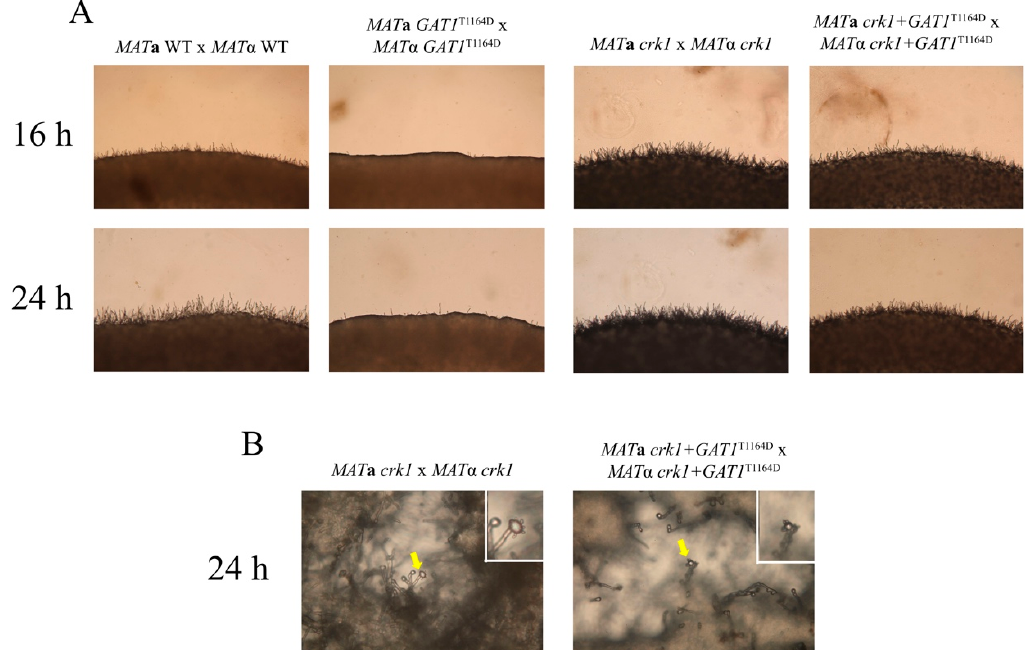
Figure 9. The GAT1 T1164D phospho-mimetic active allele dramatically repressed dikaryotic filamentation in the wild-type cross but showed slight effects on mating under crk1 mutant background. ( A ) C. neoformans MAT a and MAT α strains were crossed as indicated. Mating was conducted on V8 agar plates and incubated at 26 ° C in the dark. Photos were taken 16 h and 24 h post-incubation at 100× magnification. ( B ) Small photos demonstrate the basidia in the crk1 and crk1GAT1 T1164D bilateral mutant crosses respectively. Yellow arrow indicates basidium. Photos were taken 24 h post-incubation at 400× magnification.